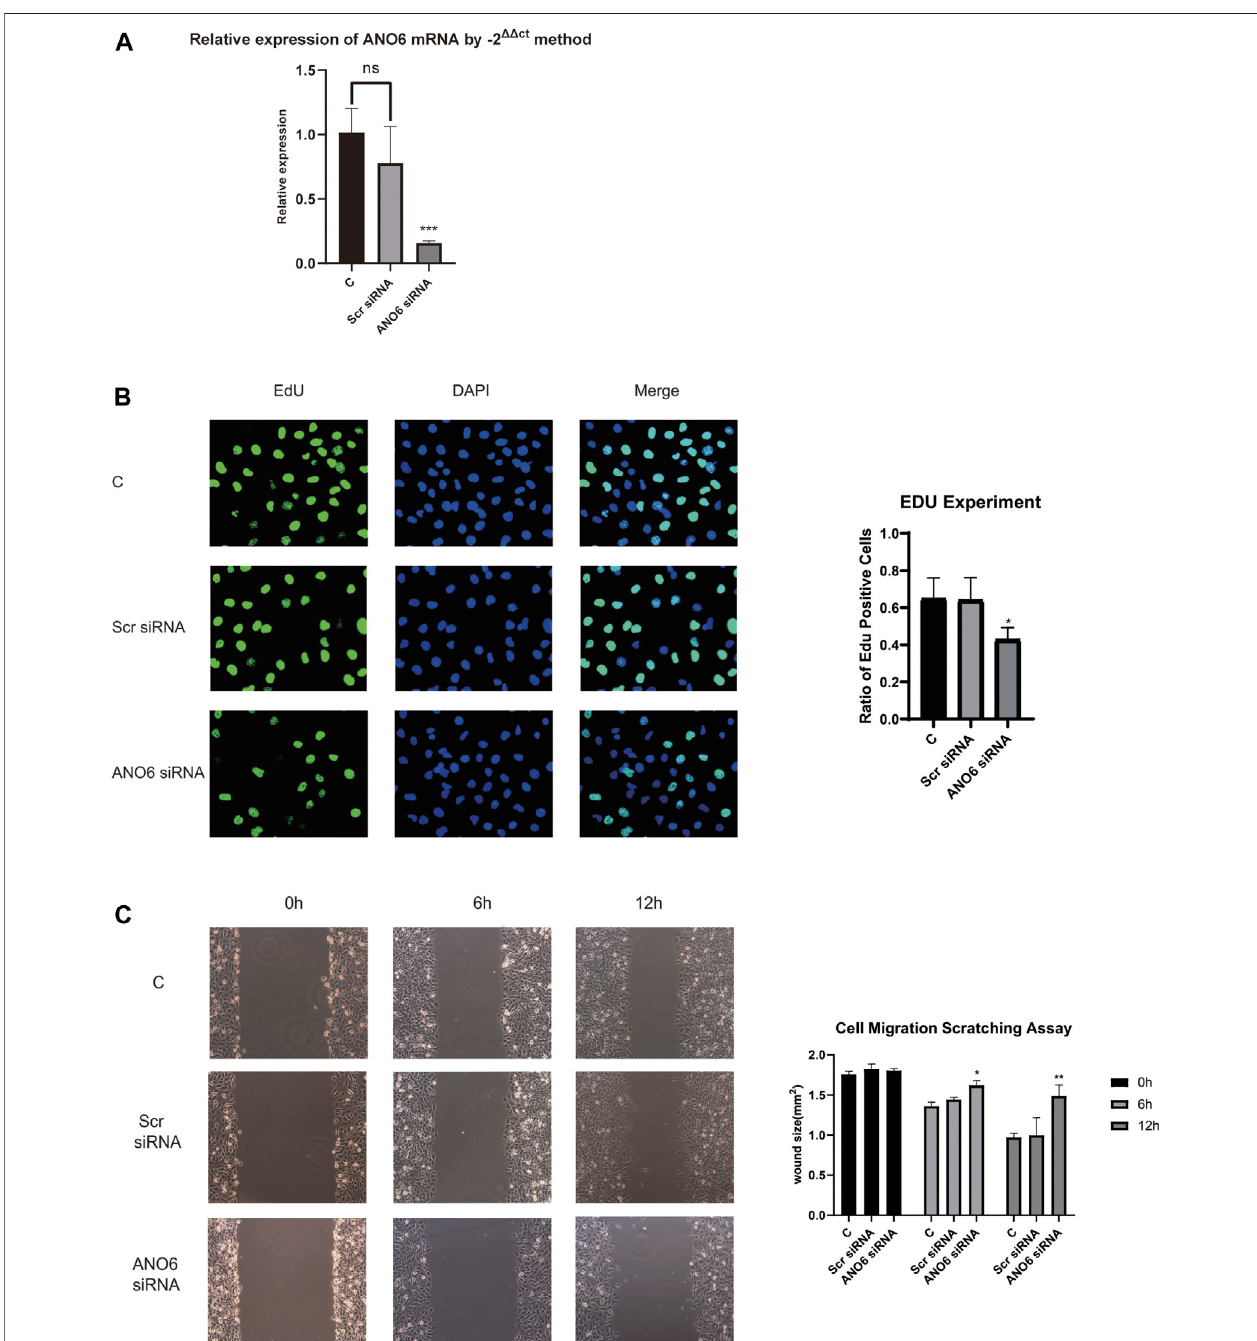
FIGURE 11 | Cell experiments of gene ANO6 to verify our results. (A) Firstly, RT-qPCR analysis was performed to validate the knockdown of gene ANO6 mRNA. The level of ANO6 mRNA expression was signi fi cantly downregulated after ANO6 siRNA transfection in MUM2B cell lines, which is valid for further investigation ( p < 0.001). (B) 5-ethynyl-2 deoxyuridine(EdU)assay wasperformed totest whether theknockdownofgeneANO6 couldin fl uence uveal melanoma cell proliferation invitro . After knockdown of ANO6 gene, the in MUM2B cell lines showed a signi fi cant decrease in nuclear DNA synthesis, indicating the ANO6 gene may progress the proliferation of uveal melanoma cell lines, which sheds light on further study. The results were statistically signi fi cant ( p < 0.05). (C) Scratch assays showed that after the knockdown of ANO6 mRNA, MUM2B cells migrated slower than scrambled siRNA or mock-treated control cells, which means that ANO6 knockdown may attenuate the migration of uveal melanoma cells. The results were of statistical signi fi cance ( p < 0.05).